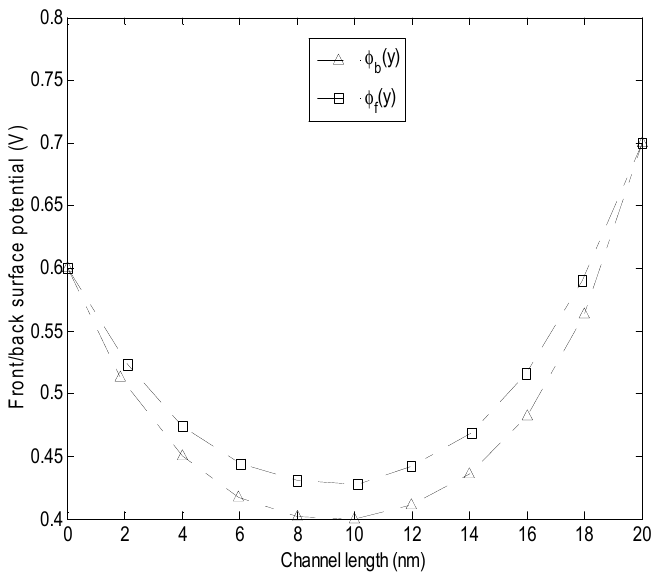
Figure 3. Front and back gate surface potential versus channel length.